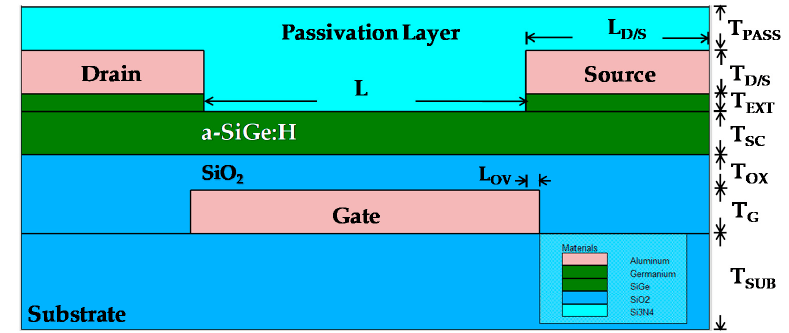
Figure 2. Bottom-gate top-contact coplanar TFT structure and its geometrical parameters used for 2D numerical simulations.